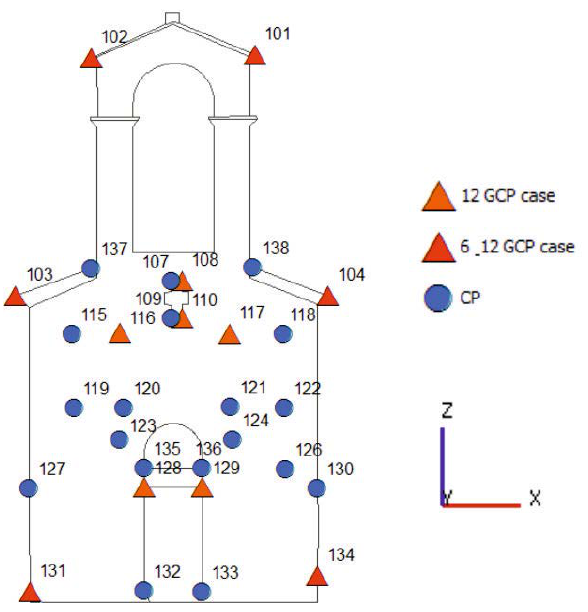
Figure 6. Façade GCPs and CPs map.